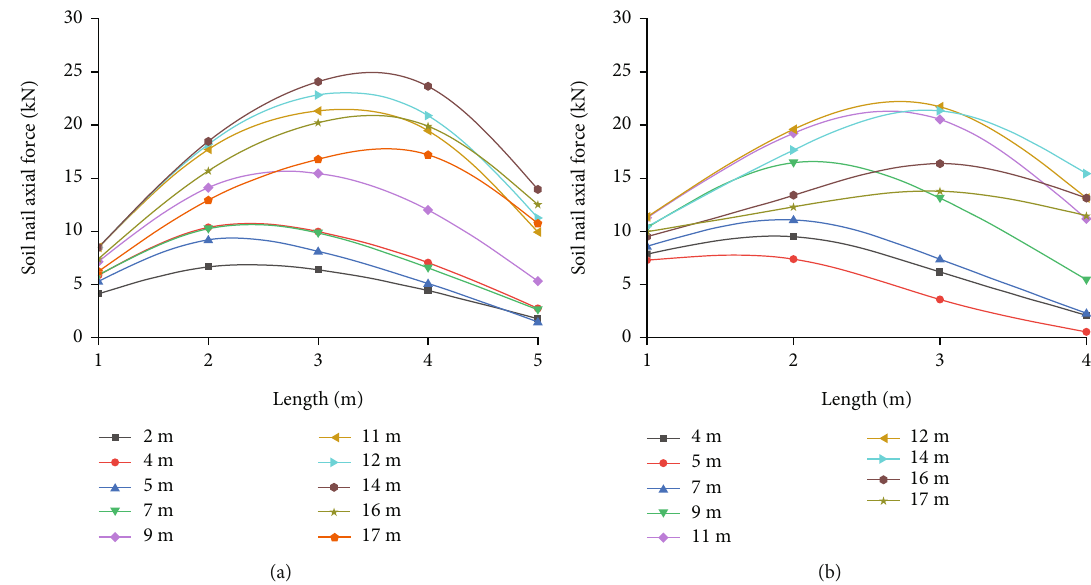
Figure 11: Along the length of anchor axial force distribution curve of the second row of soil nails. (a) Distribution curve of axial force of fi rst-row soil nailing. (b) Second-row soil nailing axial force distribution curve.